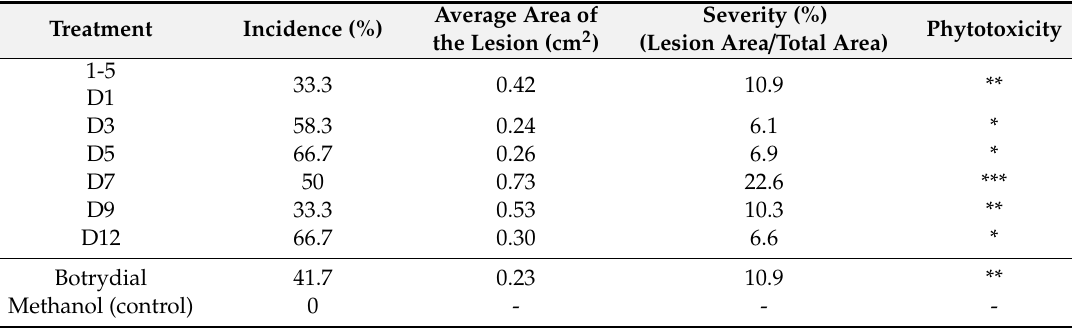
Table 4. Incidence and severity in tomato leaves caused by extracts of B. cinerea .